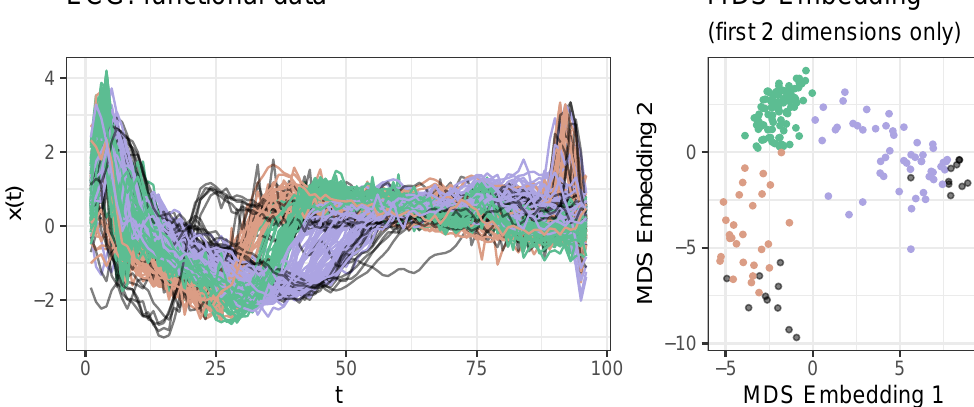
Figure 5. ECG curves and first two embedding dimensions (of five). Colors highlight subgroups apparent in the embeddings. Potential outliers with 5D-embedding LOF scores